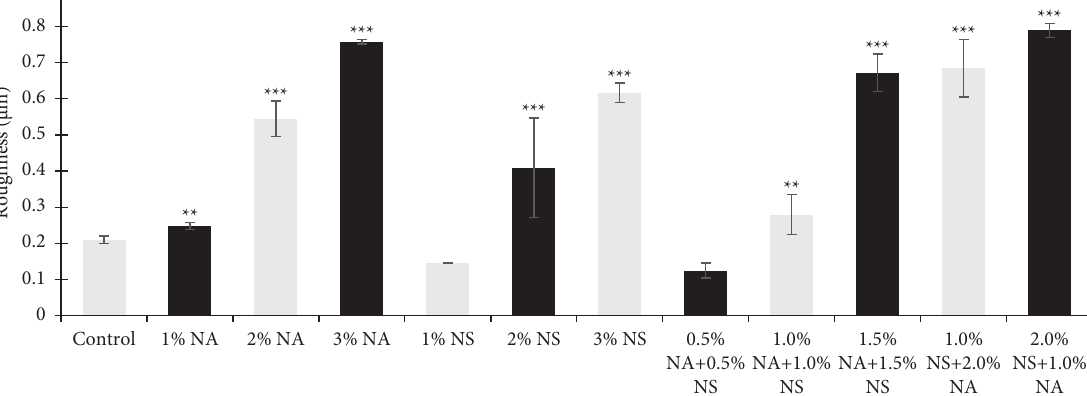
Figure 4: Roughness for diferent wt. % of nanoalumina (NA), nanosilica (NS), and a hybrid nanoparticle HySA. ∗∗ P < 0 . 01, ∗∗∗ P < 0 .